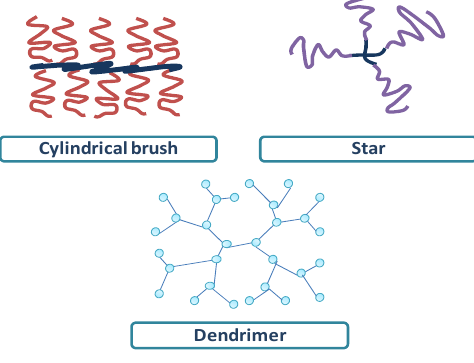
Figure 7. Schematic representation of branched polypeptide based complex architectures described within this